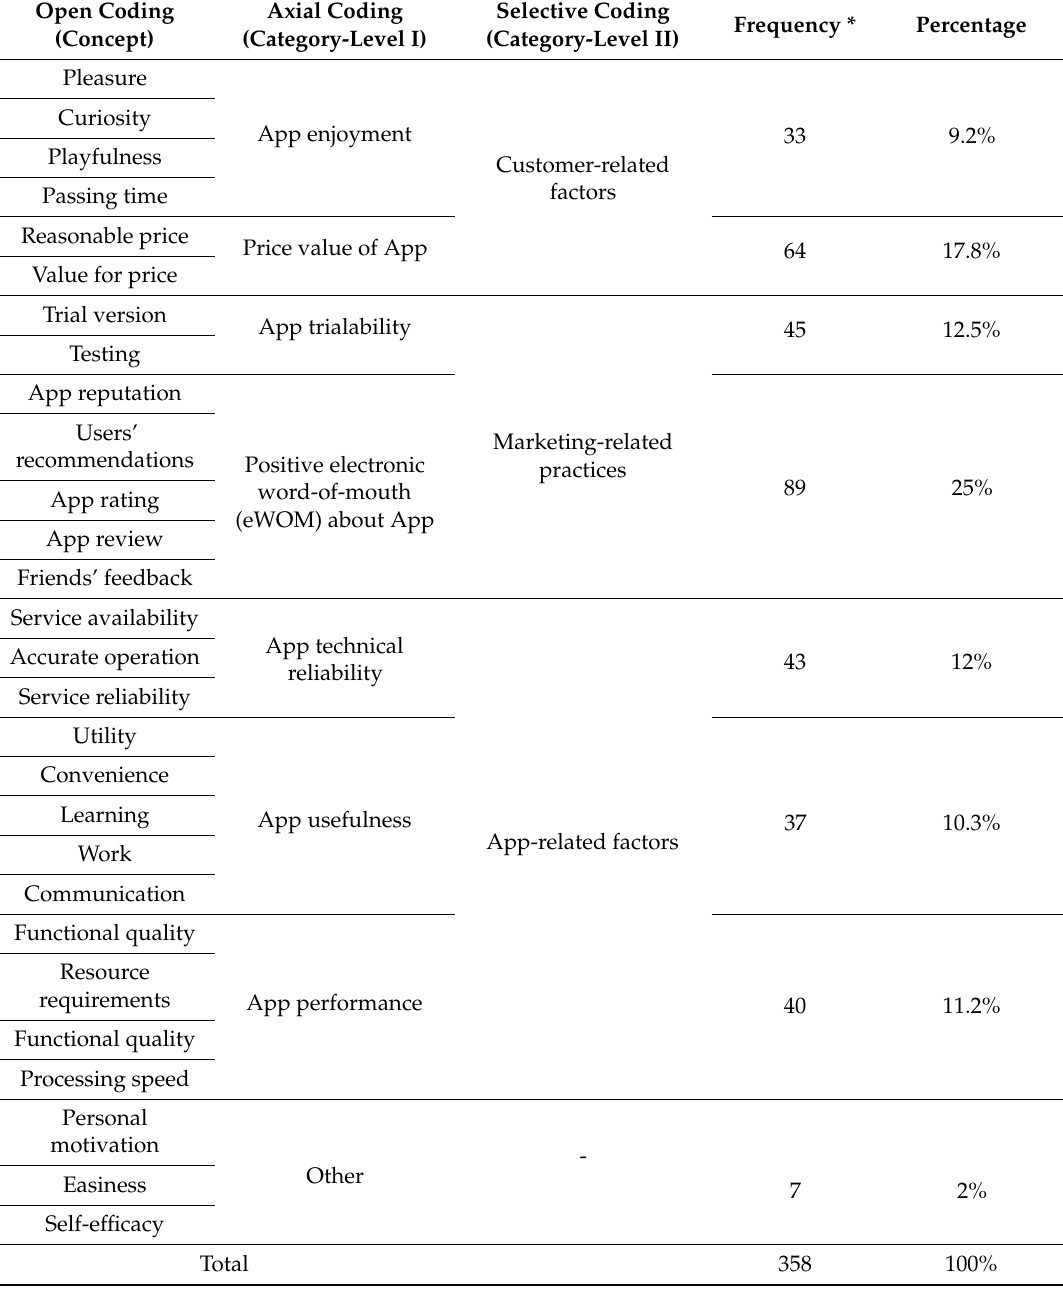
Table 1. Results of open and axial